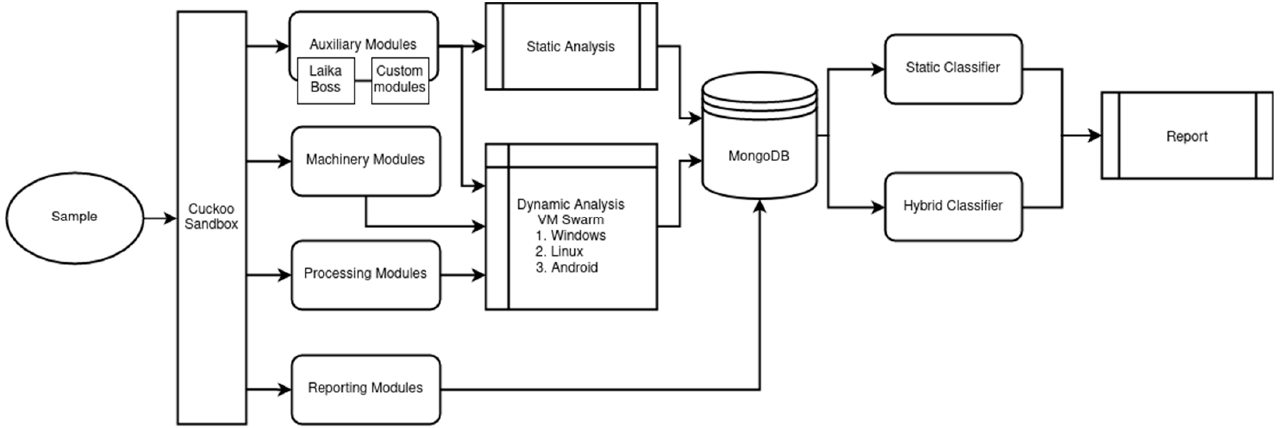
Figure 2. Sisyfos implementation diagram.